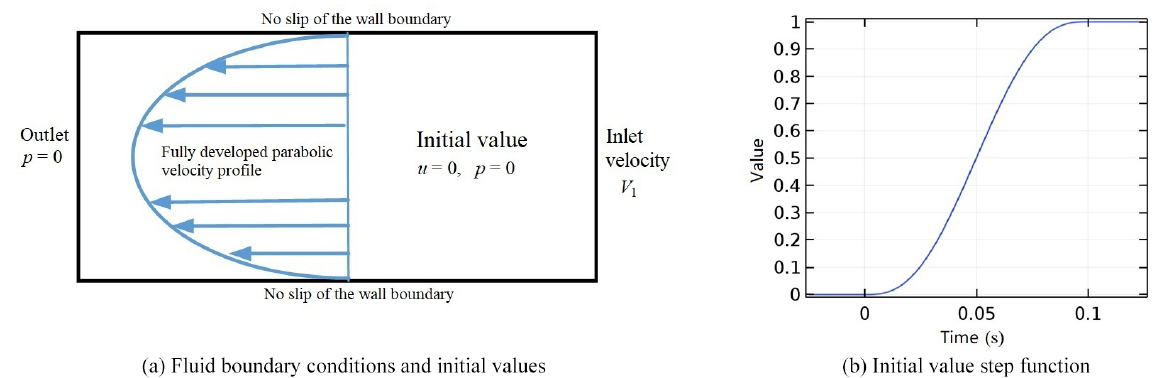
Figure 8. Fluid boundary conditions and initial value step function. (a) Fluid boundary conditions and initial values. (b) Initial value step